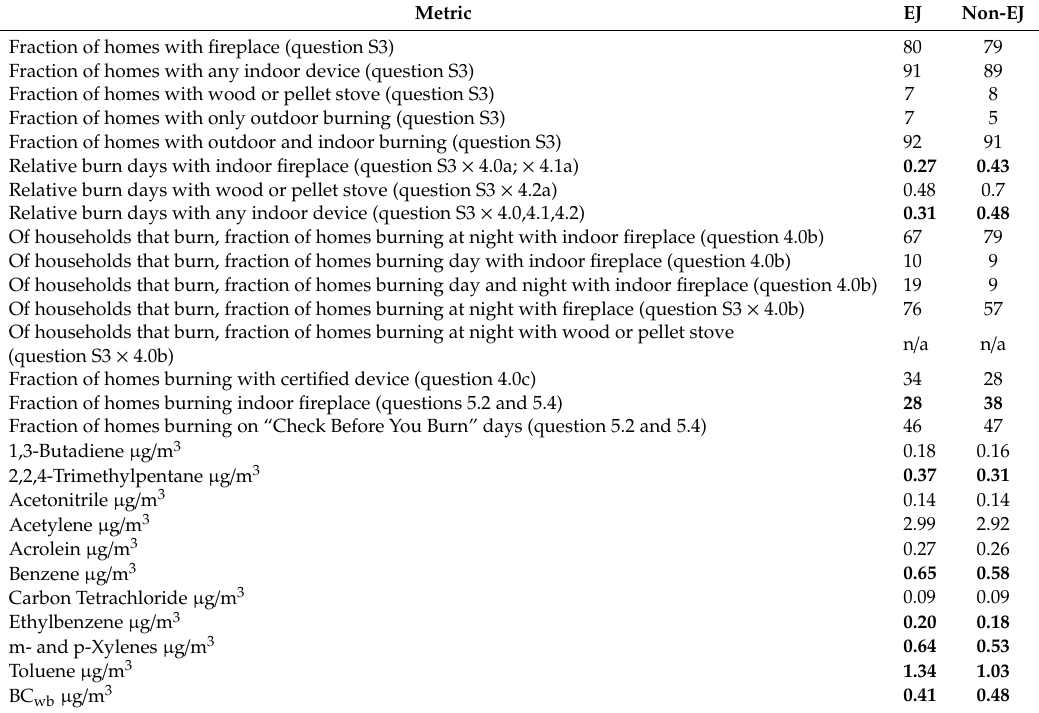
Table 6. Summary of survey results by EJ and non-EJ area, plus average concentrations of HAPs and BC wb ( µ g / m 3 ) by EJ and non-EJ area. Bold indicates significant di ff erences at the 95% confidence level via the Mann–Whitney U-test; “question” indicates the survey question from which the data are derived (see Supplementary Materials for the list of